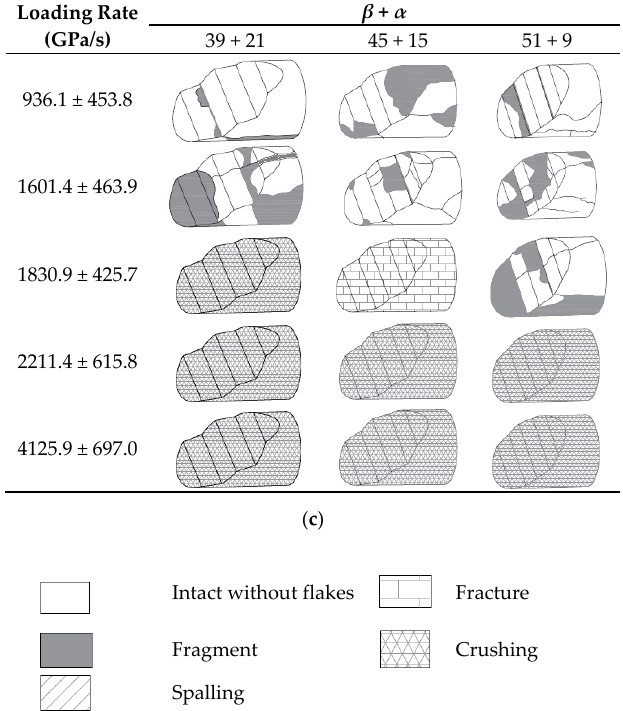
Figure 6. Three-dimensional (3D) sketch of representative specimens after the SHPB test, ( a ) α = 0°, ( b ) β + α = 45°, ( c ) β + α = 60°.